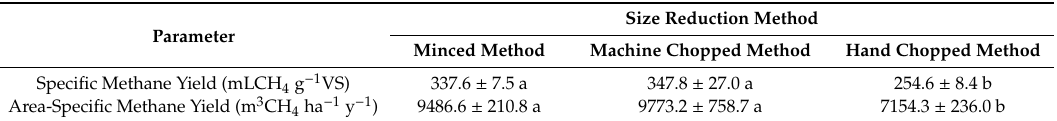
Figure 2. Specific methane yield over time for the three size reduction methods ( n = 3). Table 3. Yields of King Grass of 44-day age according to the size reduction method ( n = 3 where standard deviation is presented) (numbers of a same parameter followed by the same letter are not significantly different ( p = 0.05)).